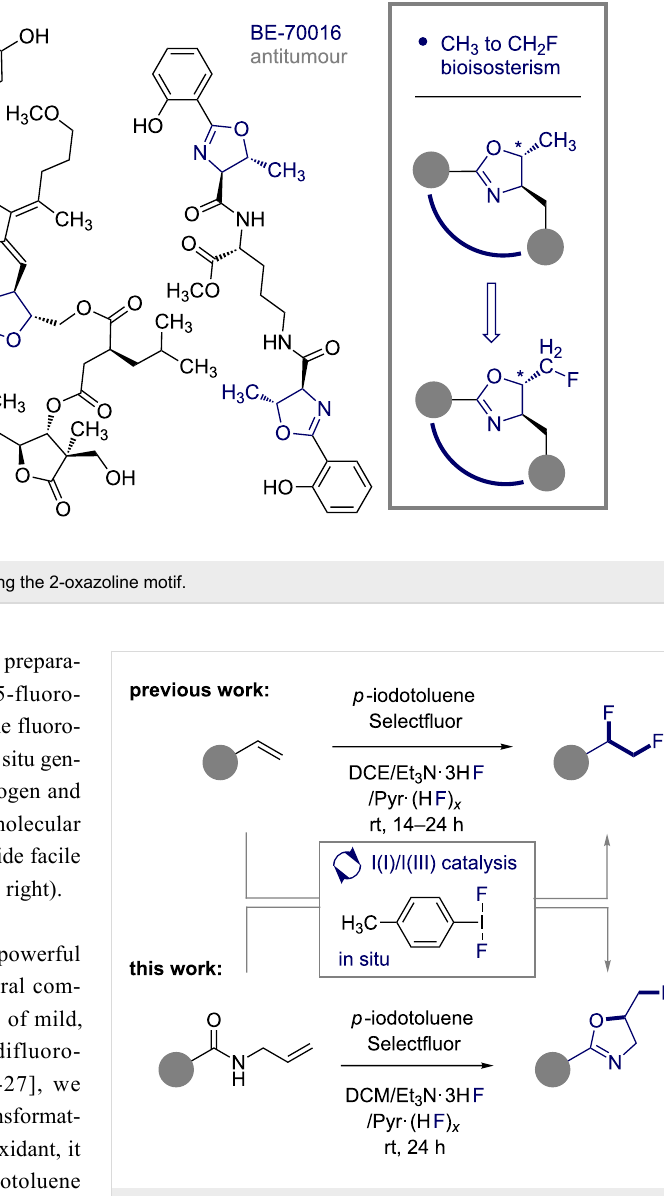
Figure 2: The catalytic difluorination of alkenes (top) and the pro- posed fluorocyclisation via the same I(I)/I(III) manifold (bottom).